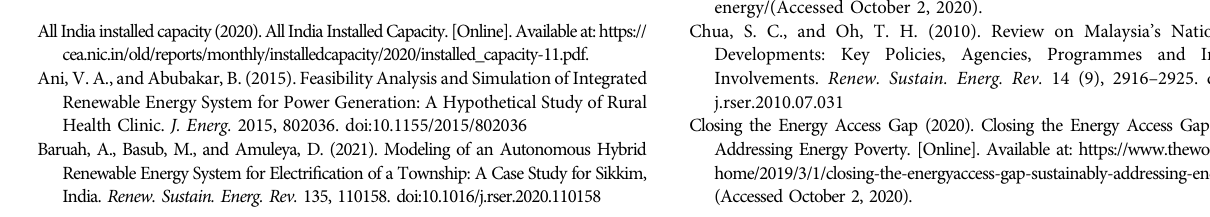
Frontiers in Energy Research |